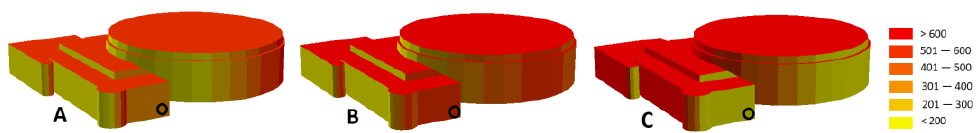
Table 4. Solar irradiance at the Municipal Swimming Pool in W/m 2 on 23 June 2021.